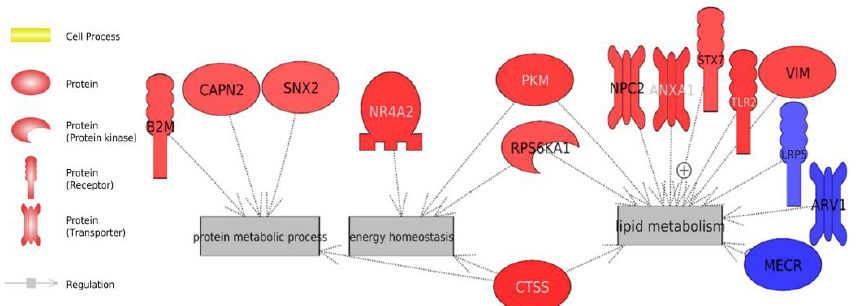
Figure 5. DEGs involved in protein metabolism, energy homeostasis and lipid metabolism using Pathway Studio software. Highlighted in red are genes over-expressed in the LRFI group and in blue are under-expressed genes in the LRFI group. Gray arrows indicate an unknown regulation effect. Previously, in Figure 3, we showed 33 genes involved in the immune response and oxidative stress, i.e., almost 38% of the total 88 DEGs.